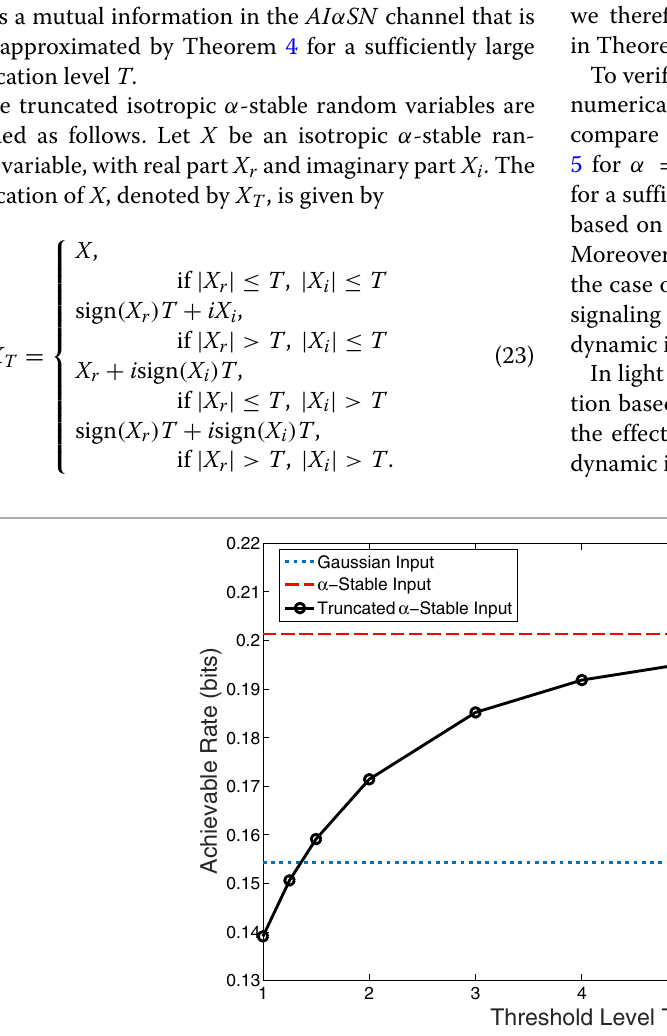
Fig. 4 Achievable rates for an AI α SN channel with α = 1.7, σ N = 0.1 and a constraint E [ | X | ] ≤ 1. The curves correspond to a Gaussian input, an isotropic α -stable input and a truncated isotropic α -stable input (defined in